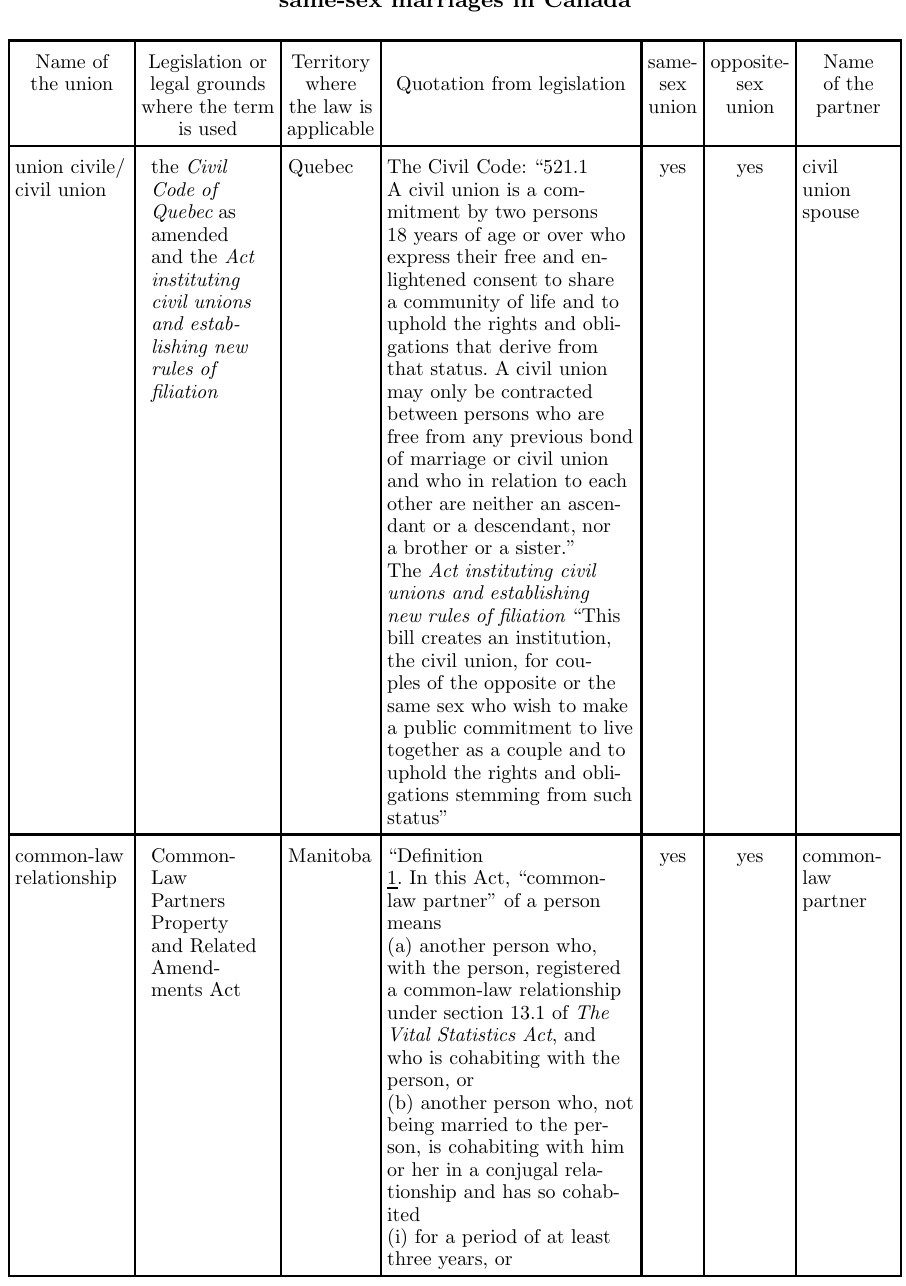
Table 3 Juxtaposition of terminology used in some jurisdictions registering same-sex marriages in